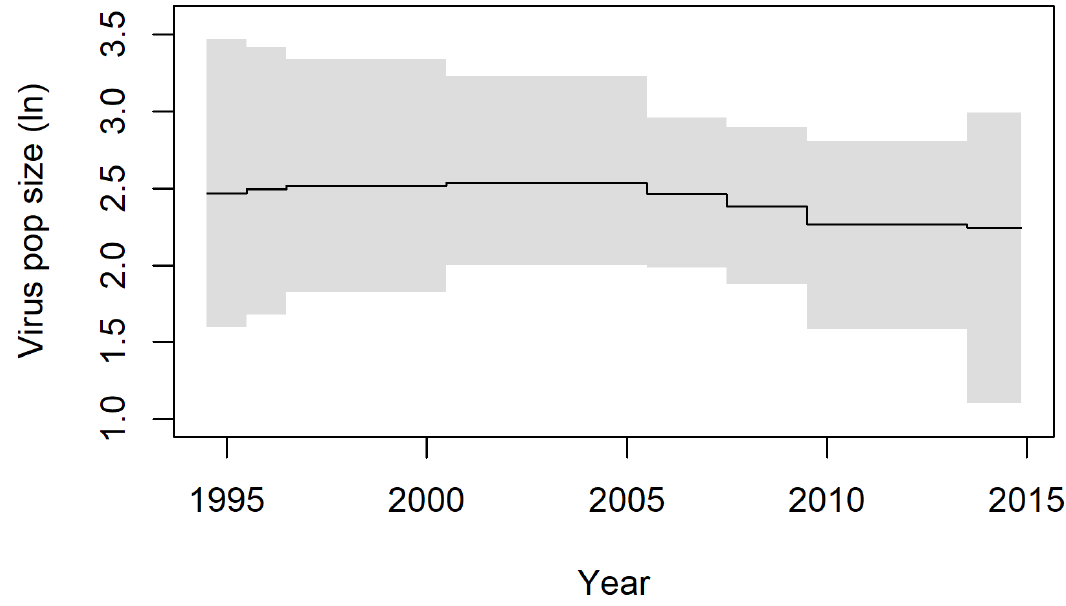
Figure 5. Skygrid analysis of RCV-A1. Details on the epochs used in the analysis are in Table 1. Shaded areas show the 95% Highest Probability Density and solid lines are the medians.